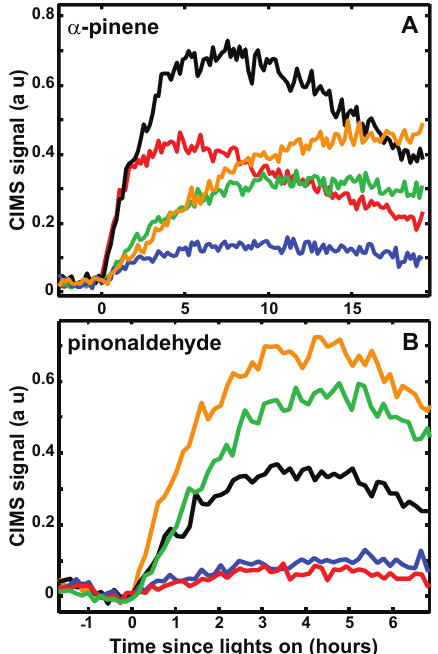
Time since lights on (hours) Fig. 4. Comparison of CIMS signals from low − NO x photoox- idation of (A) α -pinene and (B) pinonaldehyde; m/z ( − )285 (black), m/z ( − )269 (red), m/z ( − )257 (orange), m/z ( − )219 (blue), and m/z ( − )203 (green). Pinonaldehyde photooxidation produces pinonic peroxyacid observed at both m/z ( − )285 and ( − )219, pinonic acid observed at both m/z ( − )269 and ( − )203, and a C 9 hy- droperoxide observed at m/z ( − )257. The pinonaldehyde photoox- idation products are observed from α -pinene photooxidation along with additional first-generation signals at m/z ( − )269 and ( − )285 from first-generation photooxidation